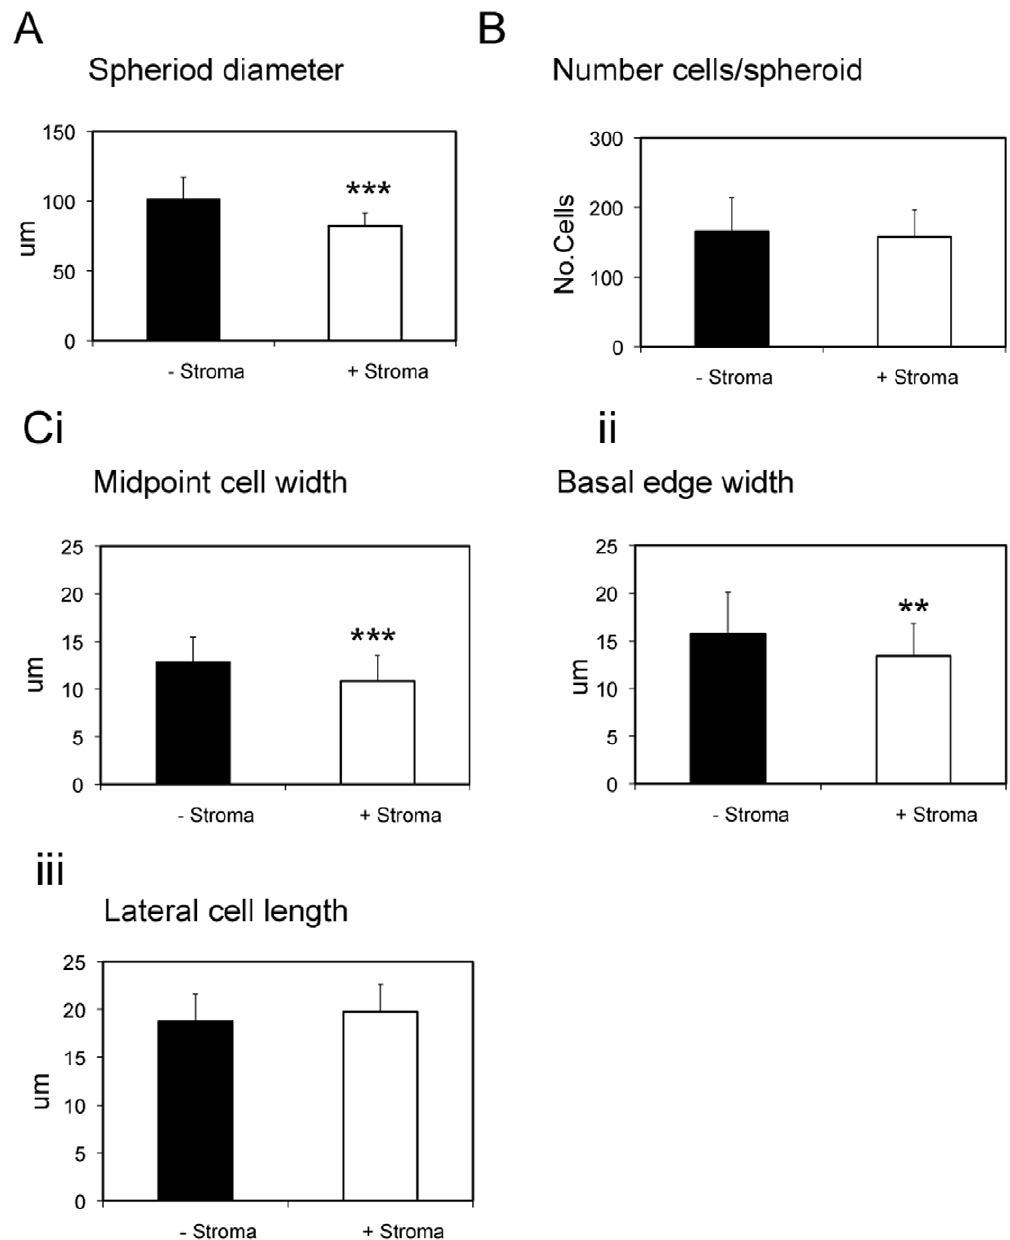
Figure 4. Stroma decreases spheroid size by decreasing cell width. (A) The diameter of 3D BPH-1 acini was measured in the presence or absence of stroma after 7 days in culture. Fifty acini cultured with stroma and 50 cultured without stroma were measured at mid-sections. The data represents five separate experiments, which were performed with different stromal cultures and Matrigel batches. (B) The number of cells within BPH- 1 acini cultured with and without stroma were counted, according to Pearson et al. [22]. The cells from 10 spheroids were counted per condition and the experiment was repeated twice. (C) The width of individual cells within acini were measured at the mid-point of the cell (Ci) and at the basal edge of the cell (Cii). The length of individual cells was measured at their longest point (Ciii). Fifty cells were measured from a minimum of 10 spheroids per condition. The data represents three experiments, ***p , 0.0005, **p , 0.005, *p , 0.05 (paired t-test). doi:10.1371/journal.pone.0018796.g004 characteristics of the microenvironment, such as deformability and tensile strength. The conflict of our findings and those of EMT are highlighted by the upregulation of genes associated with EMT in our microarray analysis, such as hepatoctye growth factor (HGF) ( + 9.6 fold). During EMT, HGF functions to dissociate epithelial cell adhesions (scattering) and increase migration in monolayer culture [44], but clearly HGF did not induce scattering in 3D.